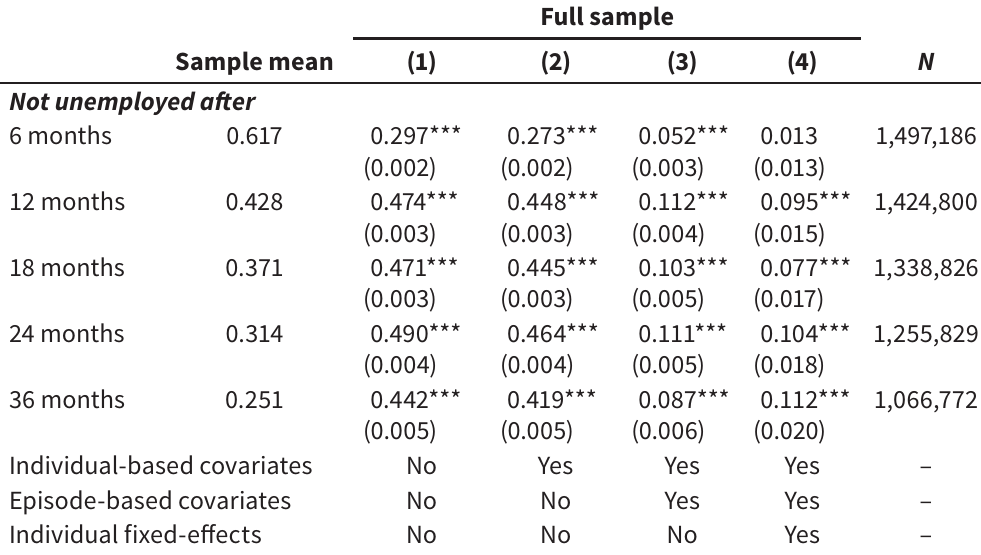
Results, unemployment re-entry: full sample